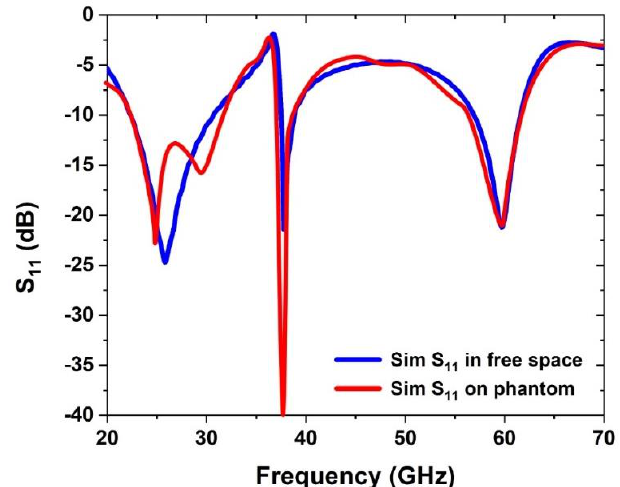
Figure 14. Comparison of the S 11 in free space and on phantom.